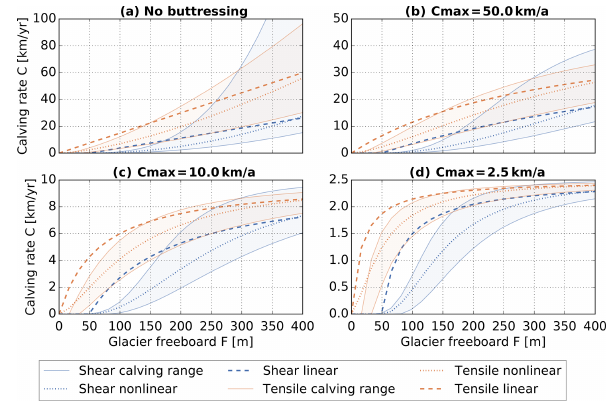
Figure 5. Calving rates as a function of glacier freeboard (ice thick- ness – water depth) in the unbuttressed case and for a range of upper bounds C max . Shear calving and tensile calving rates depend also on the water depth: two lines are shown for each configuration, the lower line for a dry cliff ( w = 0 . 0) and the upper line for a cliff at floatation ( w = 0 . 8). This spans the range of possible calving rates for a given freeboard. Also shown are the nonlinear (dotted line) and linear (dashed lines) approximations to these calving laws. In the tensile case, calving commences with freeboard F = 0, while shear calving only happens for freeboards larger F c ≈